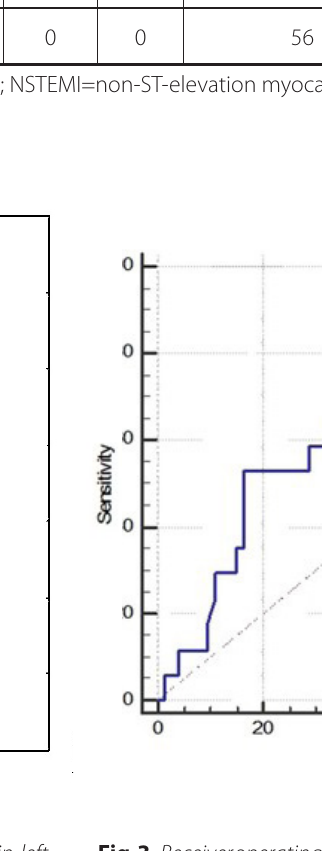
Fig. 2 - Comparison of patients with a significant decrease in left ventricular ejection fraction (LVEF) ≥ 10% and patients with preserved ejection fraction in proadrenomedullin (proADM)